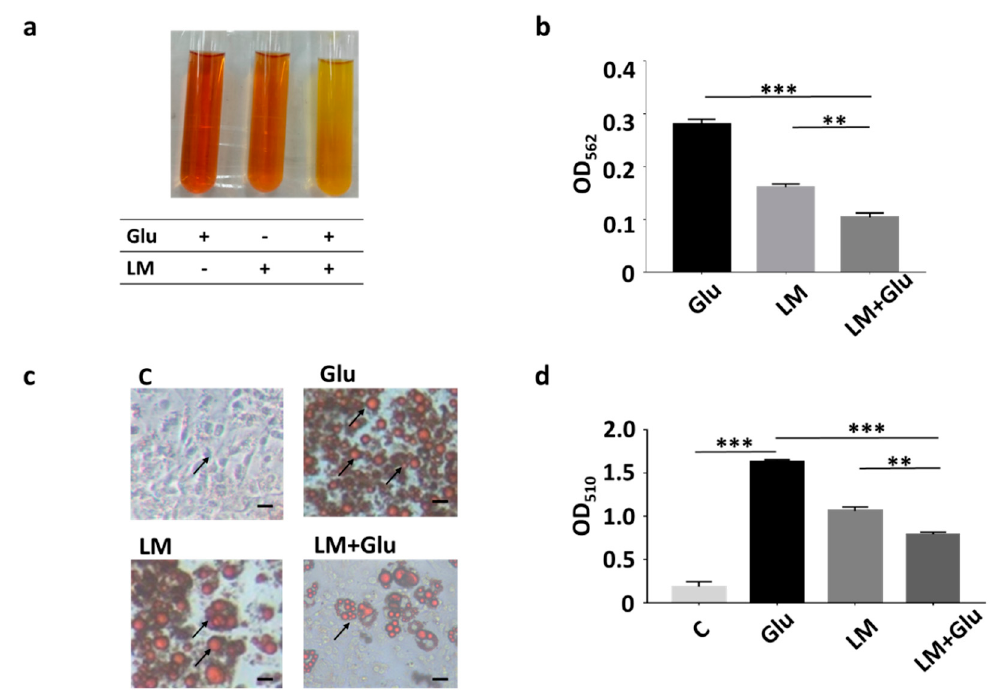
Figure 1. Inhibition of lipid accumulation of di ff erentiated 3T3-L1 cells by L. mesenteroides EH-1. ( a ) L. mesenteroides (LM) was cultured in rich media with or without the addition of 2% glucose (Glu) for 12 h. Rich media added with 2% glucose alone were included as a control. Bacterial fermentation was indicated by the colour change of phenol red from red to yellow. ( b ) Media of culture with bacteria and / or glucose were measured by OD 562. The reduction of OD 562 was detected when fermentation happened. After 12 h, the OD 562 value of L. mesenteroides (LM) with glucose (Glu) was significantly reduced (0.104 ± 0.008, n = 3) compared to that (0.270 ± 0.010, n = 3) of rich media and glucose. ( c ) 3T3-L1 cells were grown in dimethyl sulfoxide (DMEM) ( c ) or di ff erentiation media for 10 days. Di ff erentiated 3T3-L1 cells were incubated with media collected from culture of L. mesenteroides EH-1 with or without 2% glucose for 30 min. Lipid droplets (arrows) were stained by Oil Red O. ( d ) The contents of lipid droplets were quantified by measurement of OD 510 . The OD 510 value (0.793 ± 0.021, n = 3) for detection of lipid droplets in di ff erentiated 3T3-L1 cells incubated with L. mesenteroides (LM) with glucose (Glu) was significantly decreased compare to that (1.629 ± 0.027, n = 3) of cells incubated with di ff erentiation media with glucose. Data shown represent the mean ± standard deviation (SD) of experiments performed in triplicate. ** p < 0.01; *** p < 0.001. Bar = 50 µm.